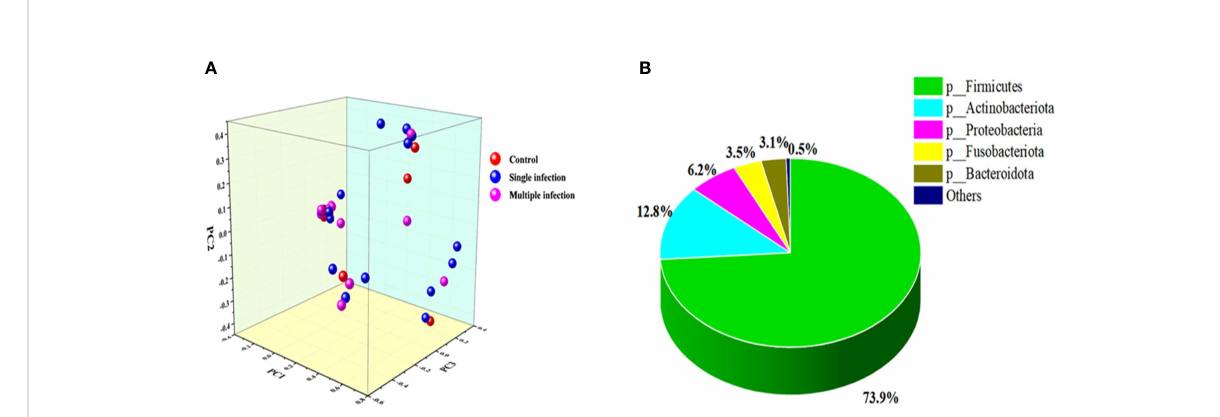
FIGURE 2 (A) PCoA pro fi le of the cohort associated with HPV-infected status displayed with weighted UniFrac distance. Each dot presents a sample, and the color is according to grouping. (B) The dominant phyla in the vaginal microbial community.